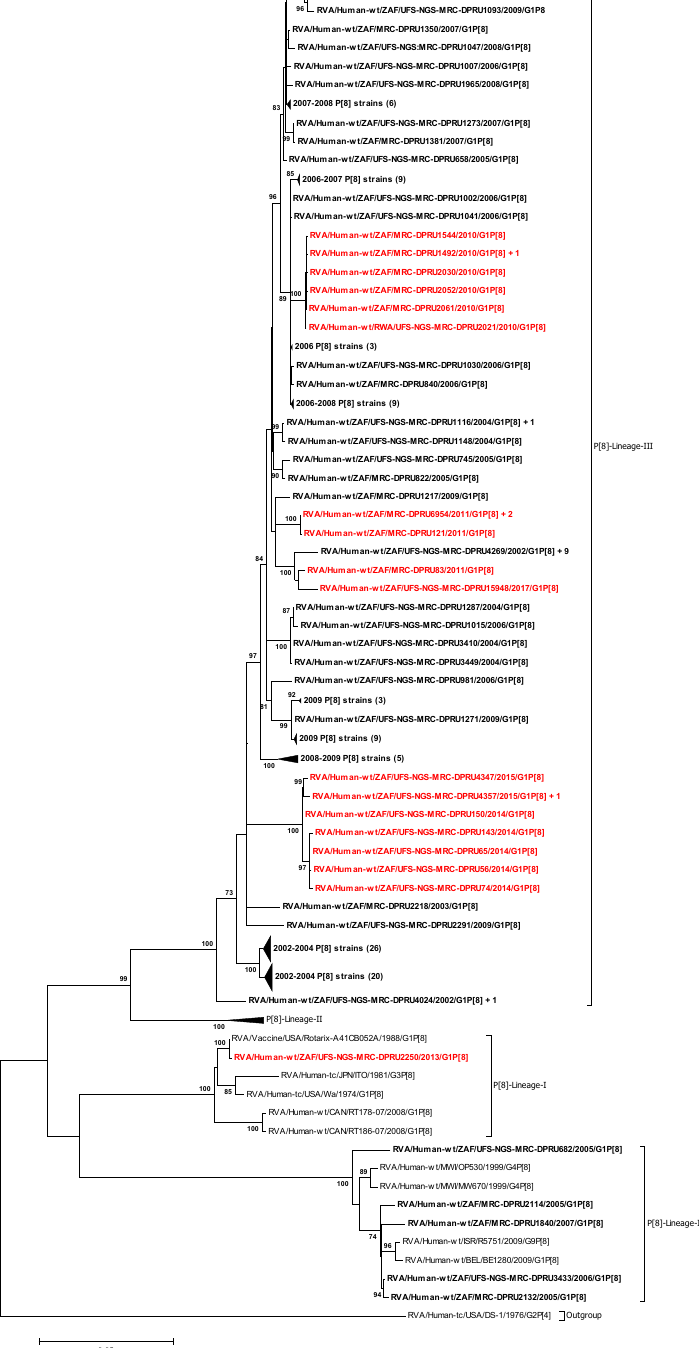
Figure 2. Maximum likelihood phylogenetic tree based on the full-length nucleotide sequences of genome segment 4 encoding VP4 protein. The GTR + G + I evolutionary model was used for phylogenetic inference. African pre-vaccine P[8] strains are highlighted in bold-face while post-vaccine strains are highlighted in bold-red. Adjacent to some sequences is indicated a plus ( + ) sign followed by the number of identical sequences (S3). The number in brackets denotes the number of compressed strains. Lineages are indicated in roman numerals. Only bootstrap values ≥ 70% are shown adjacent to each branch node. Scale bar indicates the number of nucleotide substitutions per